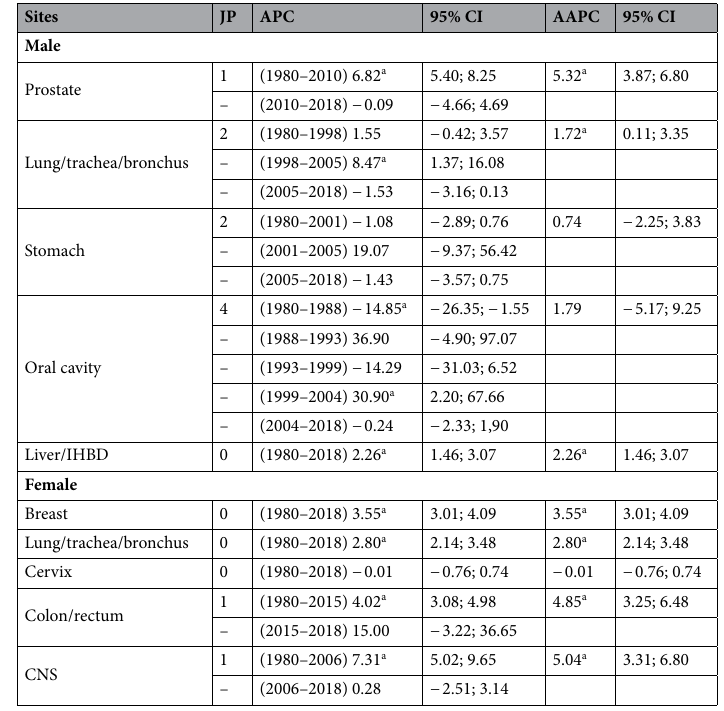
Table 4. Joinpoint analysis of cancer mortality by the main sites for age-standardized rates for both sexes. Sergipe, 1980–2018. JP number of join points, APC annual percent change, AAPC average annual percent change, CI Confidence interval, CNS central nervous system, IHBD intrahepatic bile ducts. a APC/AAPC statistically